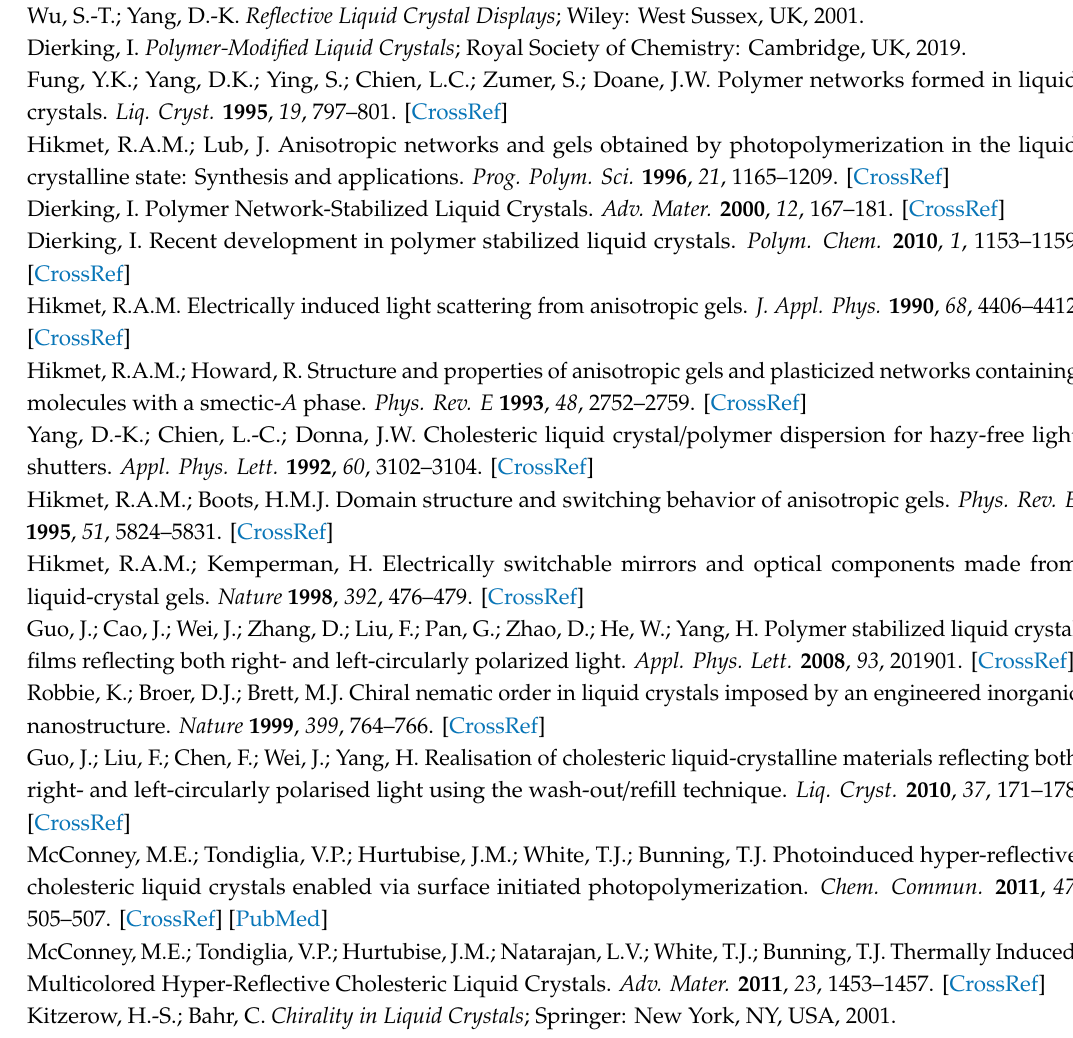
Figure S1: Transmission spectra of a negative ∆ ε PSCLC with 5 µ m thickness as a function of DC voltage. Figure S2: (a) Reflection band position and (b) response times of a PSCLC with 6% polymer content and ~15 µ m thickness as a function of DC voltage. In (a) the voltage was turned on at t = 0 and o ff at t = 30 s. Data from Ref.